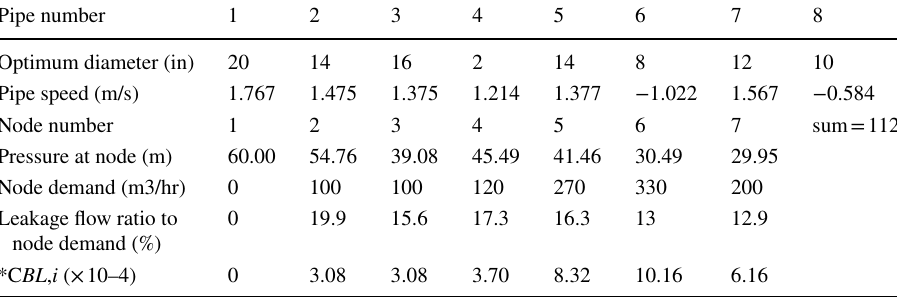
Table 5 Optimal characteristics results by the NSGA-II for two loops with pressure-dependent leak